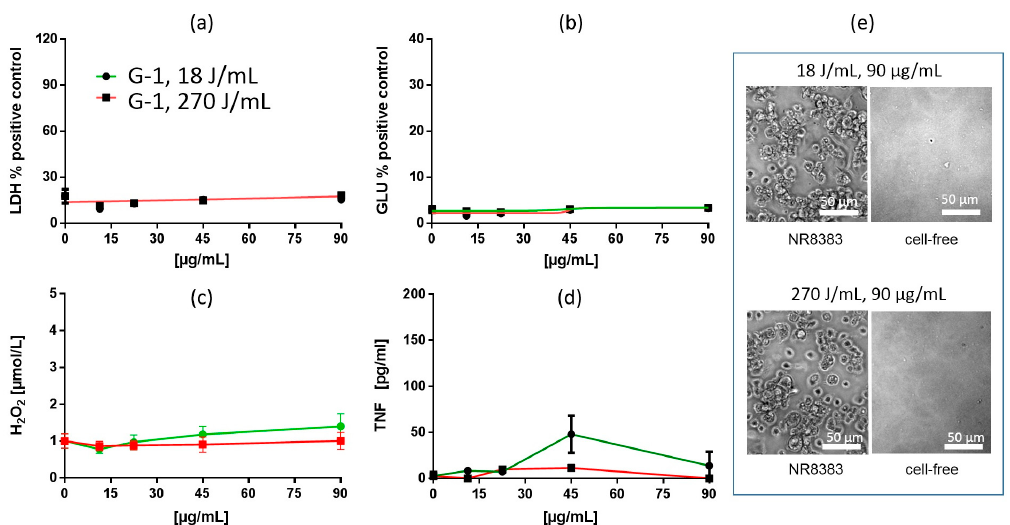
Figure 8. In vitro response of NR8383 alveolar macrophages to silica gel G-3. Particles were dispersed with either 18 J/mL (green) or 270 J/mL (red). ( a ) lactate dehydrogenase activity (LDH), ( b ) glucuronidase activity (GLU), ( c ) H 2 O 2 concentration, and ( d ) tumor necrosis factor alpha (TNF). ( e ) NR8383 cells after 16 h exposure to P-5, dispersed with 18 J/mL or 270 J/mL; right panels show particles settled onto the bottom of culture well under cell-free conditions. Numerous particles are visible under cell-free conditions and appear similar sized at 18 or 270 J/ml.